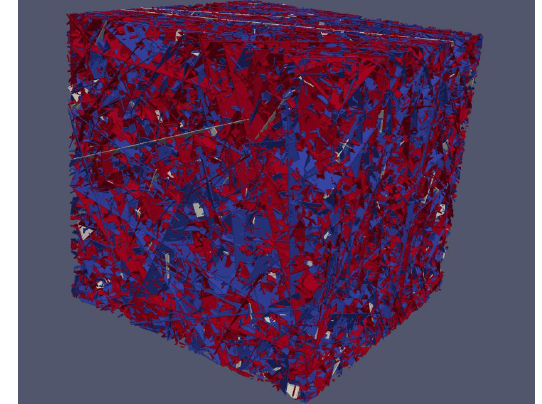
Figure 1. Sample